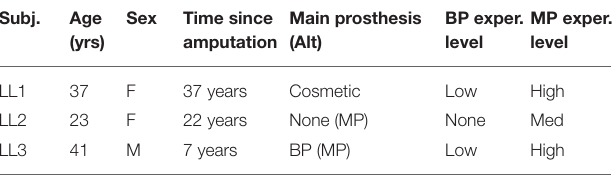
TABLE 4 | Demographics of subjects with limb